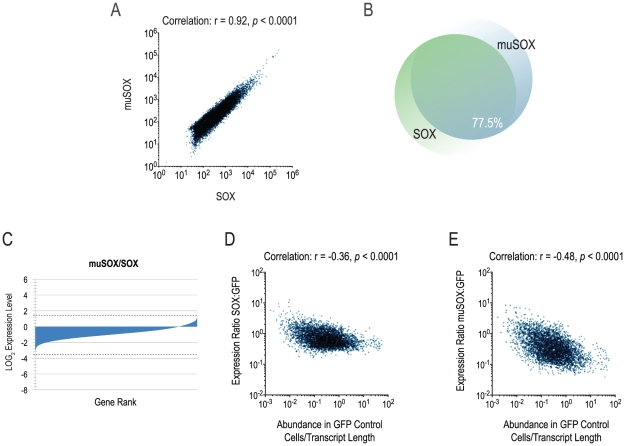
SOX and muSOX target similar pools of host mRNA.(A) Scatter plot of average spike-normalized transcript levels in SOX- vs. muSOX-expressing cells. Correlation calculated by nonparametric Spearman test with indicated r and p-values. (B) Venn diagram illustrating overlap in expression levels between SOX- and muSOX-expressing cells. The overlap is calculated from the number of genes that fall into the category of downregulated (<75% expression compared to GFP) or escape (≥75% expression compared to GFP) in both SOX and muSOX-expressing cells. (C) Ranked gene expression in muSOX- vs. SOX-expressing cells. The ratio of expression in muSOX vs. SOX-expressing cells was transformed to LOG2 and plotted on a linear scale. Dashed lines indicate maximum and minimum. (D) Inverse correlation between mRNA abundance in control cells and efficiency of shutoff by SOX. X-axis indicates spike-normalized read counts in GFP control cells and y-axis denotes ratio of expression in SOX-expressing vs. GFP-expressing cells. Correlation calculated as in (A). (E) Inverse correlation between mRNA abundance in control cells and efficiency of shutoff by muSOX as in (D).